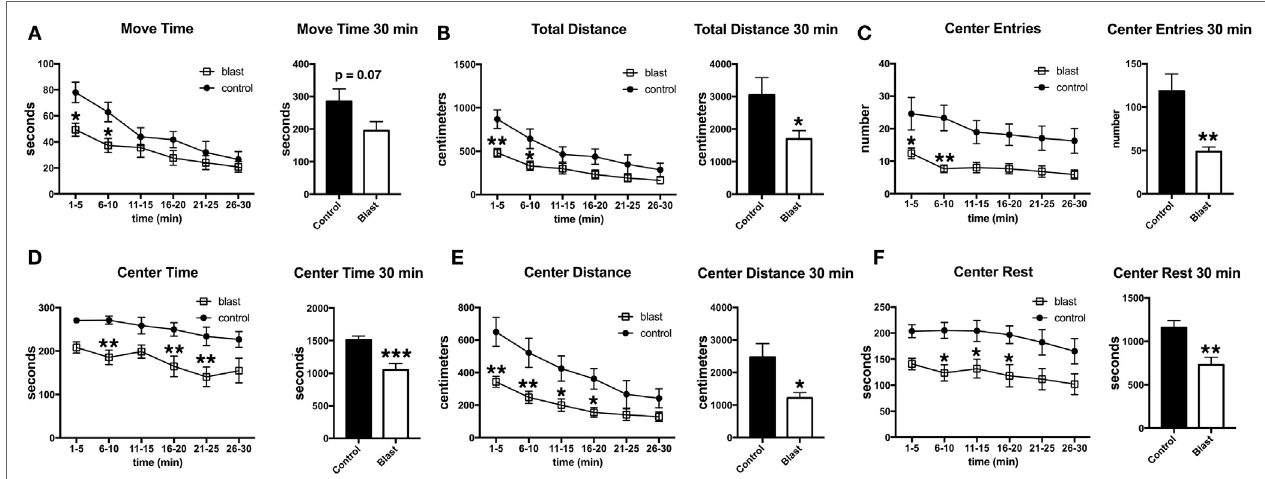
FigUre 3 | Delayed behavioral changes in blast-exposed rats at 3 days following a single predator scent exposure . Activity of blast-exposed and control rats was assessed in an open field for 30 min at 3 days after the predator scent exposure. Shown are time in motion (a) , total distance moved (B) , center entries (c) , center time (D) , distance traveled in the center (e) , and center rest time (F) . Error bars indicate ± SEM. Asterisk(s) indicate statistically significant differences between blast-exposed and control (* p < 0.05, ** p < 0.01, unpaired t